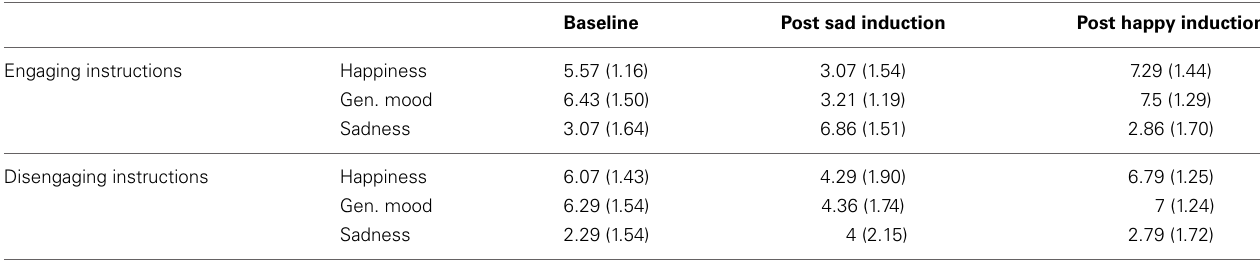
Scales of all measures range from 1 to